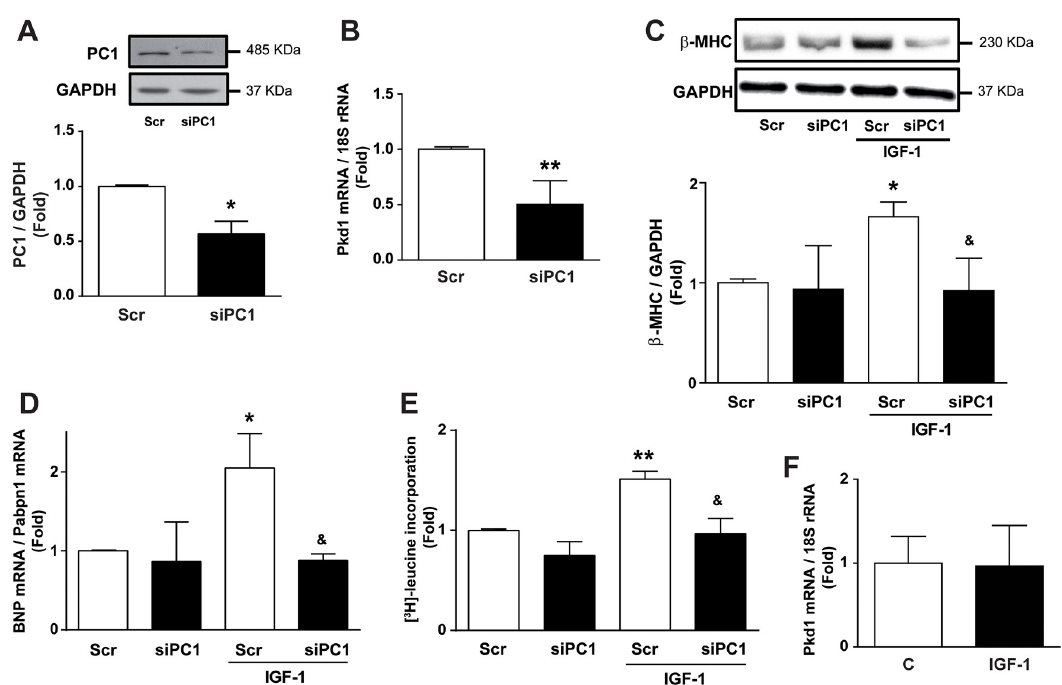
Fig 1. PC1 is required for IGF-1-induced cardiomyocyte hypertrophy. Cardiomyocytes were transfected with scrambled (Scr) or PC1 siRNA (siPC1), incubated for 24 h, and then treated with IGF-1 (10 nM) or vehicle for 24 h. (A) Representative Western blot of polycystin-1 (PC1) and GAPDH as a loading control. The lower panel shows the PC1/GAPDH ratio. (B) Bar graph of polycystic kidney disease 1 ( Pkd1 ) mRNA levels. (C) Upper panel shows representative Western blots of β -MHC and GAPDH. The graph in the lower panel shows the β -MHC/GAPDH ratio calculated by densitometric analysis. (D) Brain natriuretic peptide (BNP ) mRNA levels determined by qRT-PCR are expressed relative to Pabpn1 mRNA. (E) [ 3 H]-leucine incorporation in cardiomyocytes. (F) Bar graph shows Pkd1 mRNA levels after IGF-1 stimulus. Values are shown as mean ± SD (n = 3-6). � p < 0.05 and �� p < 0.01 vs. Scr, & p < 0.05 vs. Scr+IGF-1.